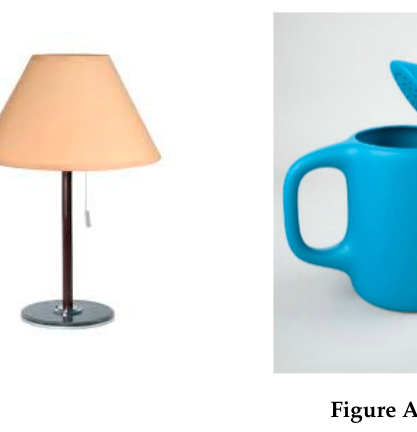
Figure A2. Negaive emotional stimuli.